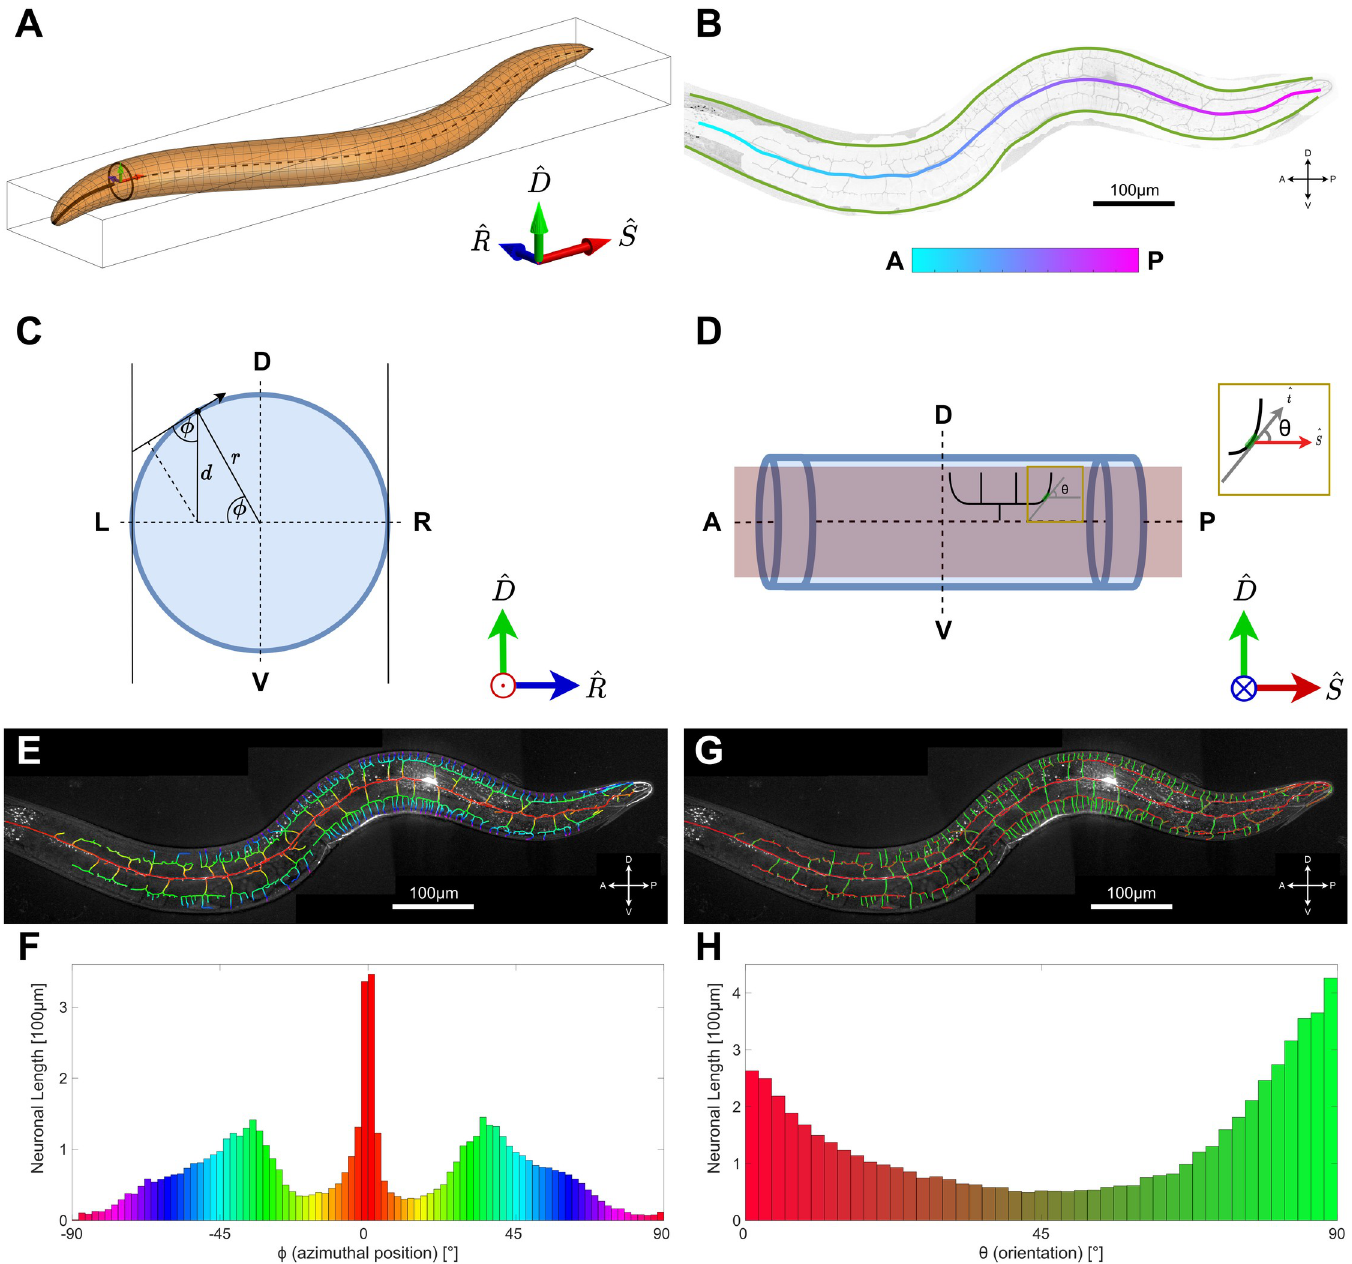
Fig 3. The worm’s coordinate system and PVD feature extraction. A. The coordinate system used to characterize the PVD neuron is defined by ð ^ S ; ^ D ; ^ R Þ ; where ^ S is locally tangential to the worm’s longitudinal axis, ^ D points along the local dorsal direction, and ^ R points in the direction of the worm’s right. B. Using the projection image of the non-planar PVD neuron, an outline image is generated using morphological operations applied to the neuron’s trace. This is used to find the neuron’s centerline and borderline. C. A schematic of the worm’s cross section. The azimuthal angle ϕ denotes the azimuthal position of PVD elements. r, radius at each point; d, distance. D. A schematic of the worm from a left/right side view. The angle θ denotes the orientation of PVD elements, defined as the angle between the longitudinal axis, ^ S , and the local tangent, ^ t . E, F. Visualization of the azimuthal angle ϕ (E) and distribution of the PVD elements for different ϕ angles (F, n = 10). The peaks at 0 and ± 35˚ correspond to the primary (red) and tertiary (green, dorsal are positive and ventral are negative values) branches. Same neuron as Fig 1A. G, H. Visualization (G) and distribution (H) of orientation angle, θ , for PVD elements (n = 10). The distribution shows that most of the neuron’s length is either parallel (red) or perpendicular (green) to the midline. D = dorsal, V = ventral, L = left, R = right, A = anterior, P = posterior.